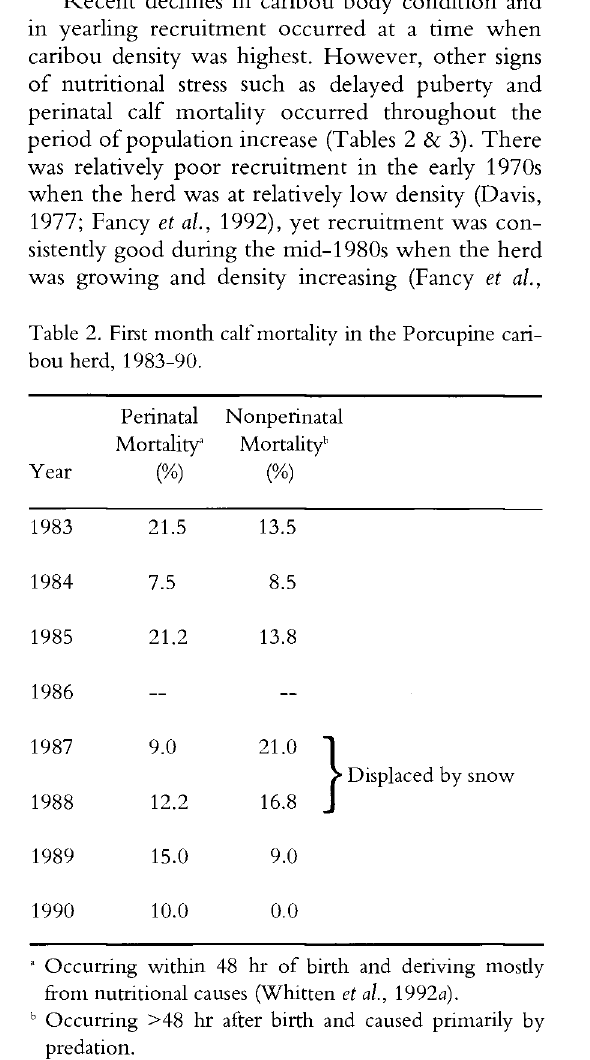
Fig. 1. Mean fall body weight and condition score of Porcupine Herd cows, 1990-93. Condition score is an index of the amount of soft tissue covering bone (5 being high, 1 low) summed for 3 sites: withers, ribs, and hips (Gerhart et al, 1992)